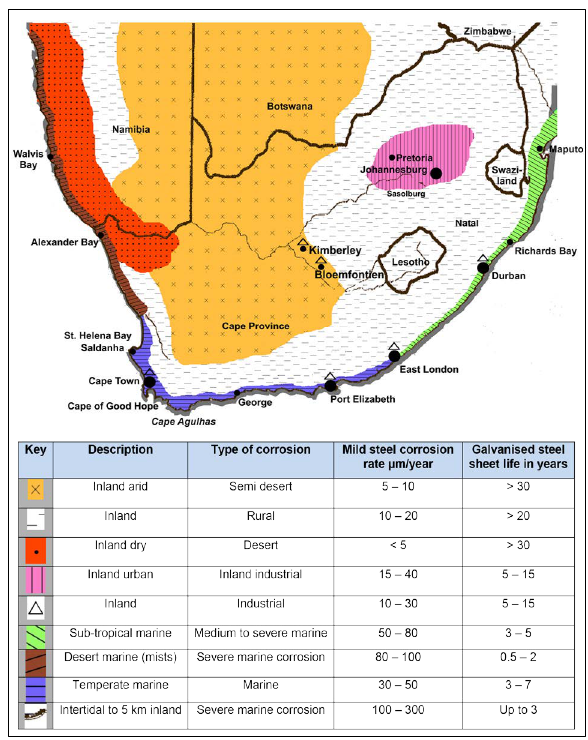
Atmospheric corrosion map of southern Africa – adapted from the Callaghan 1991 map 1 and taken from Janse van Rensburg (2010) 7